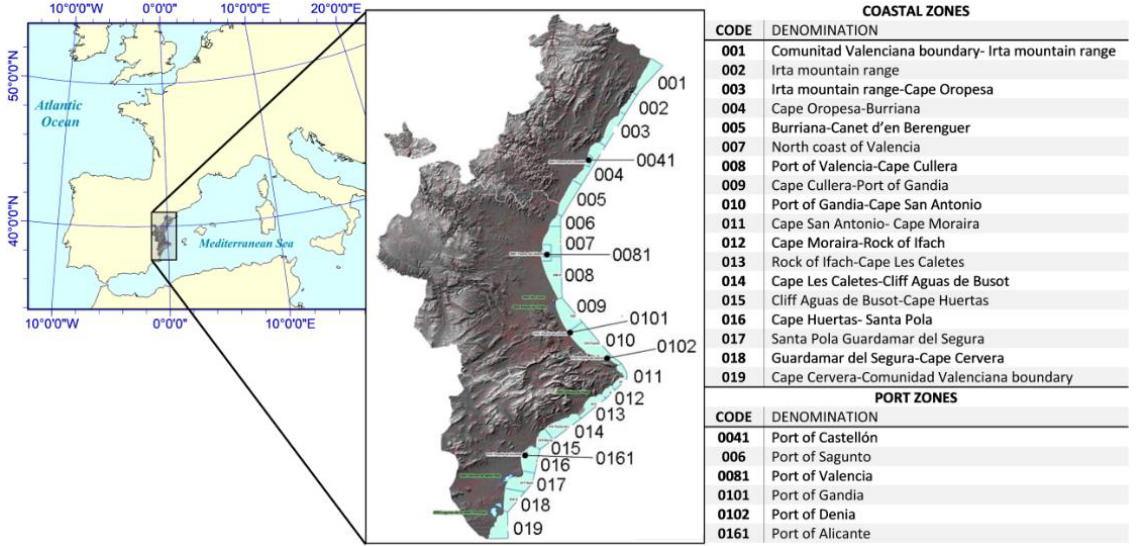
Figure 1. Study area: 24 water bodies defined along the 476 km of the Valencia coastline (Spain).